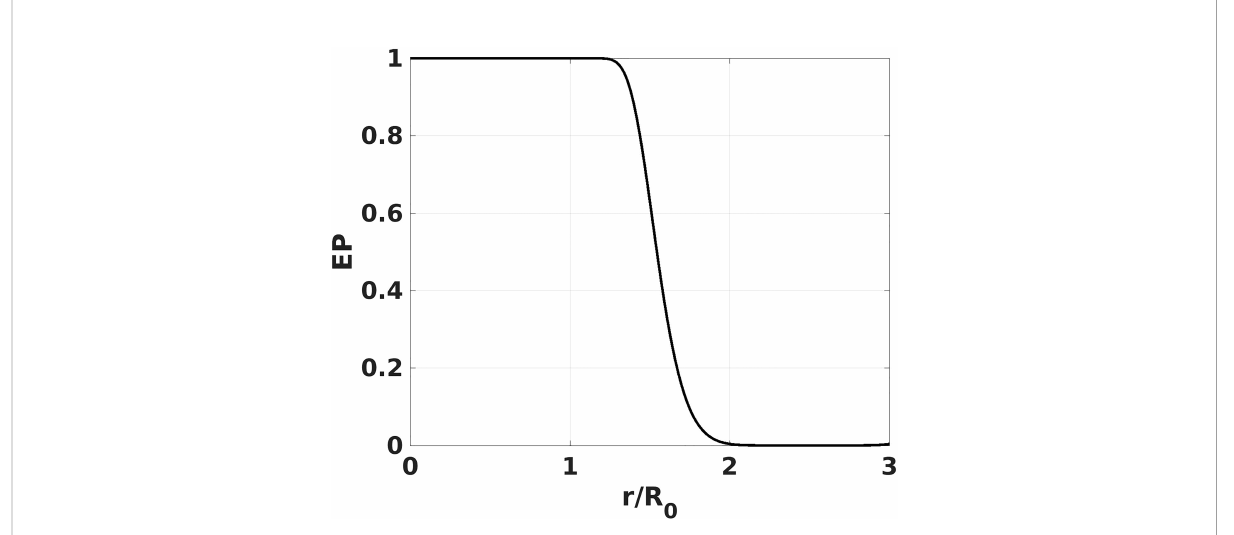
FIGURE 2 The function distribution of the implantation proportion coef fi cient EP of the 3D eddy.